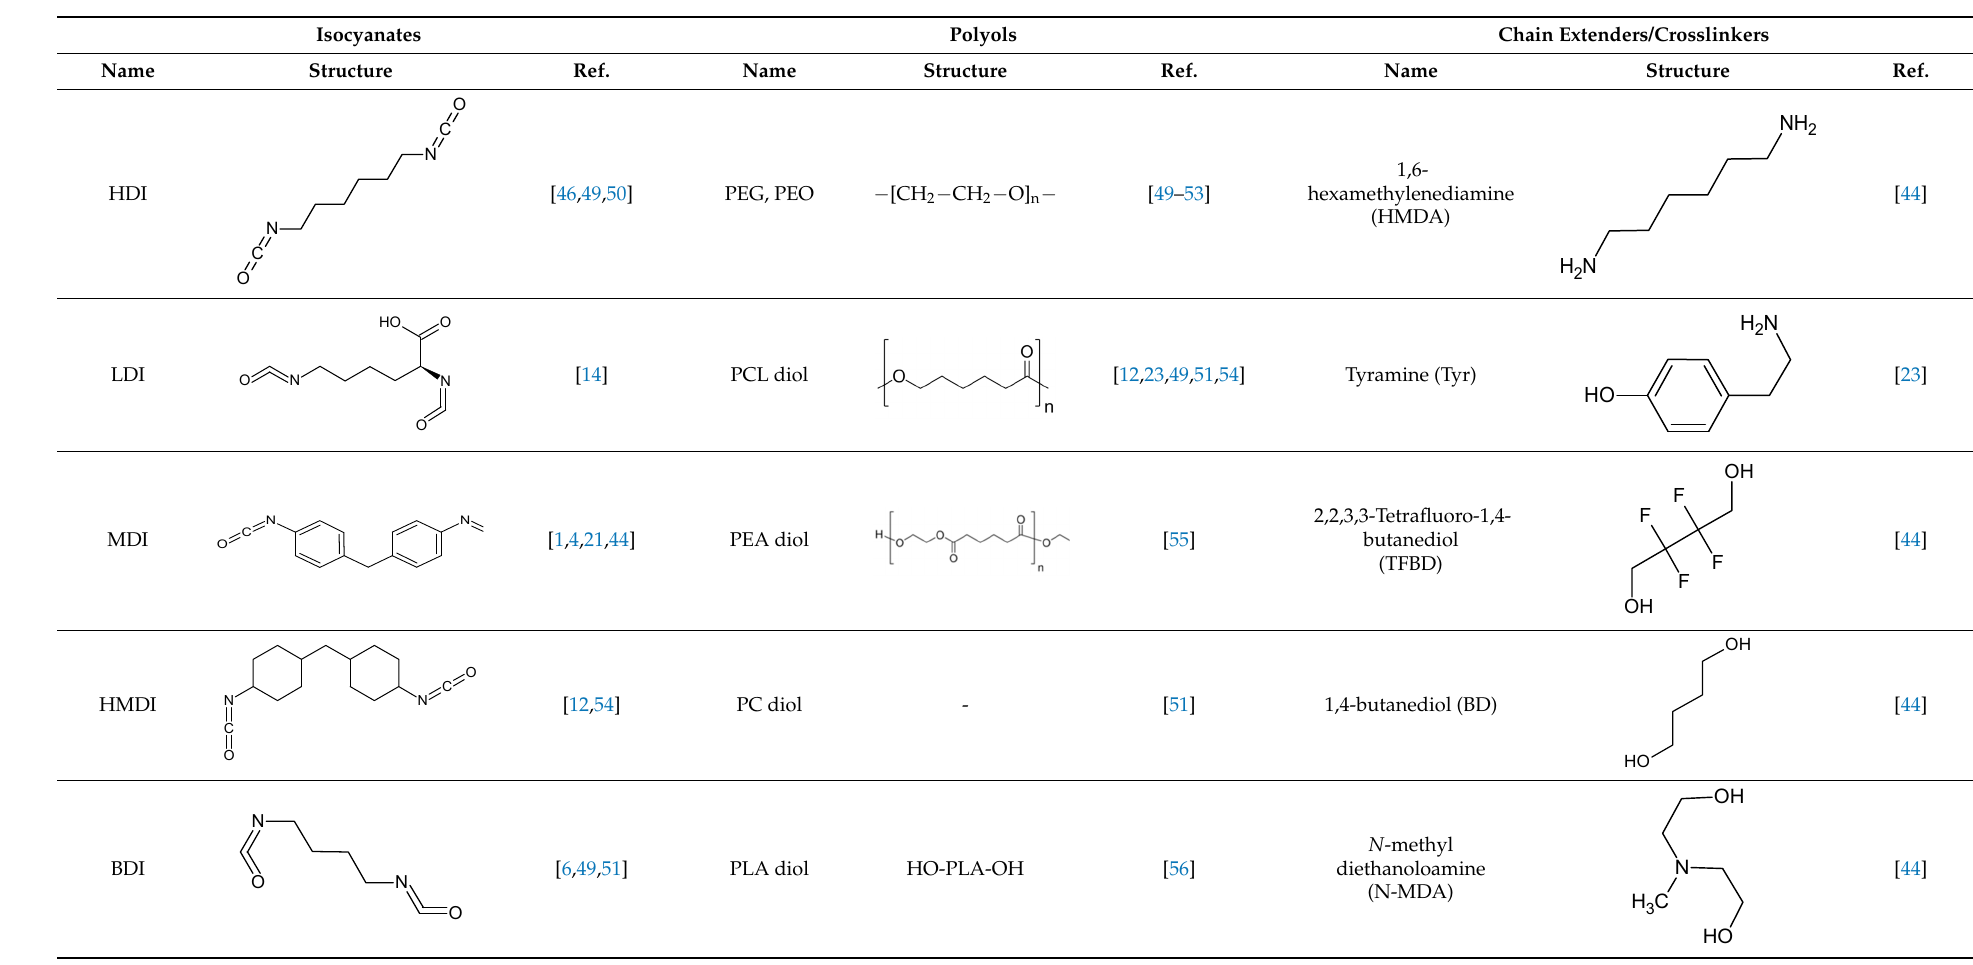
Table 2. Polyurethanes investigated for biomedical applications.